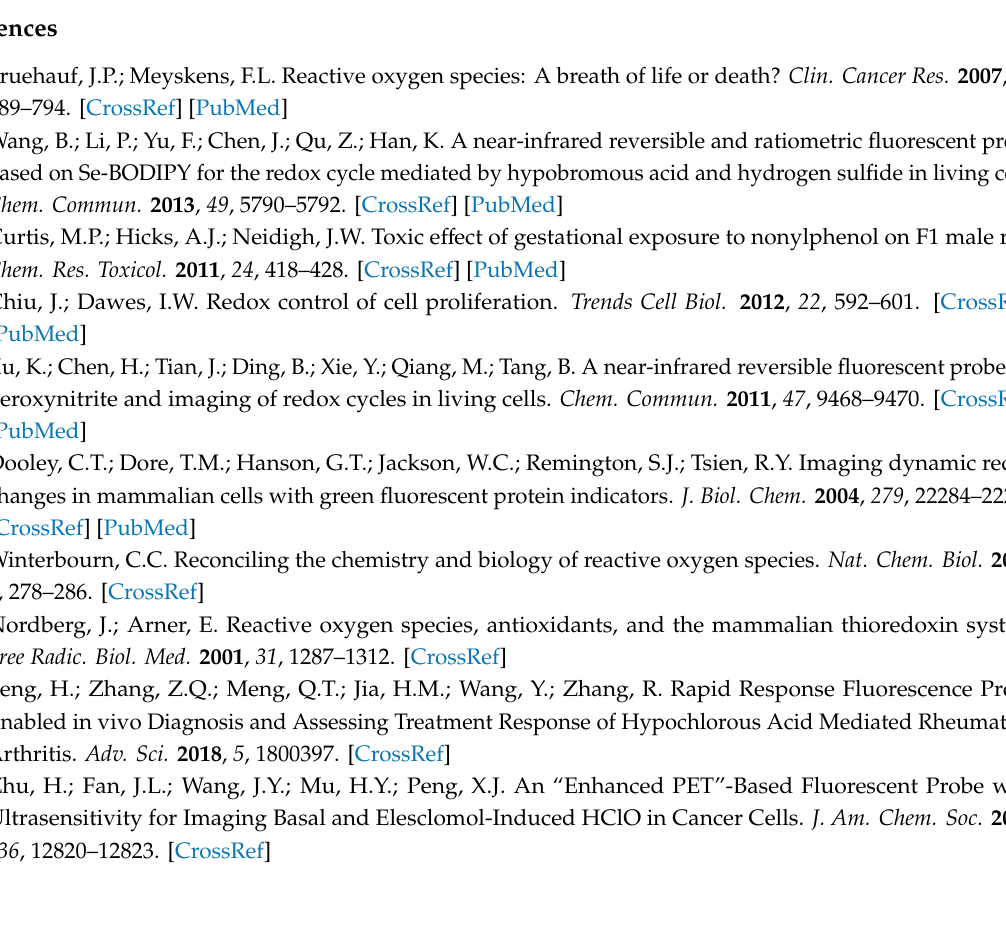
L-ol , Figure S4: The stability of L-ol , Figure S5,6: HRMS of L-ol sequential addition of HOCl and GSH, Figure S7: Linear relationship of L-ol with the concentration of HOCl. Figure S8: Absorption spectra of L-ol upon addition of various anions, Figure S9: Linear relationship of L-one with the concentration of GSH, Figure S10: UV-vis absorption spectra of L-one in the presence of various analytes, Figure S11: The color changes of L-one towards various competitive